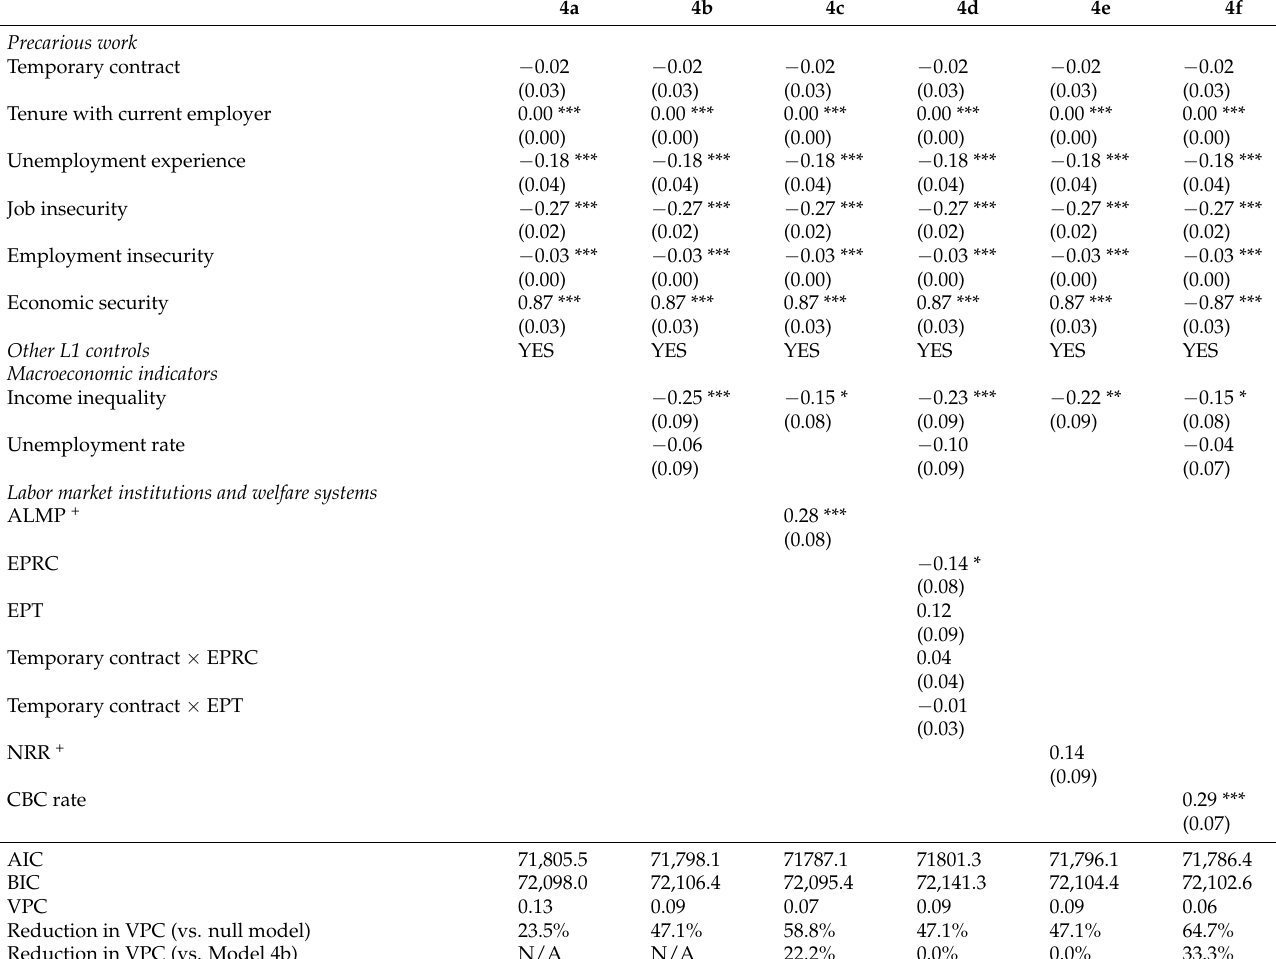
Table 4. Impact of labor market policies and welfare systems on